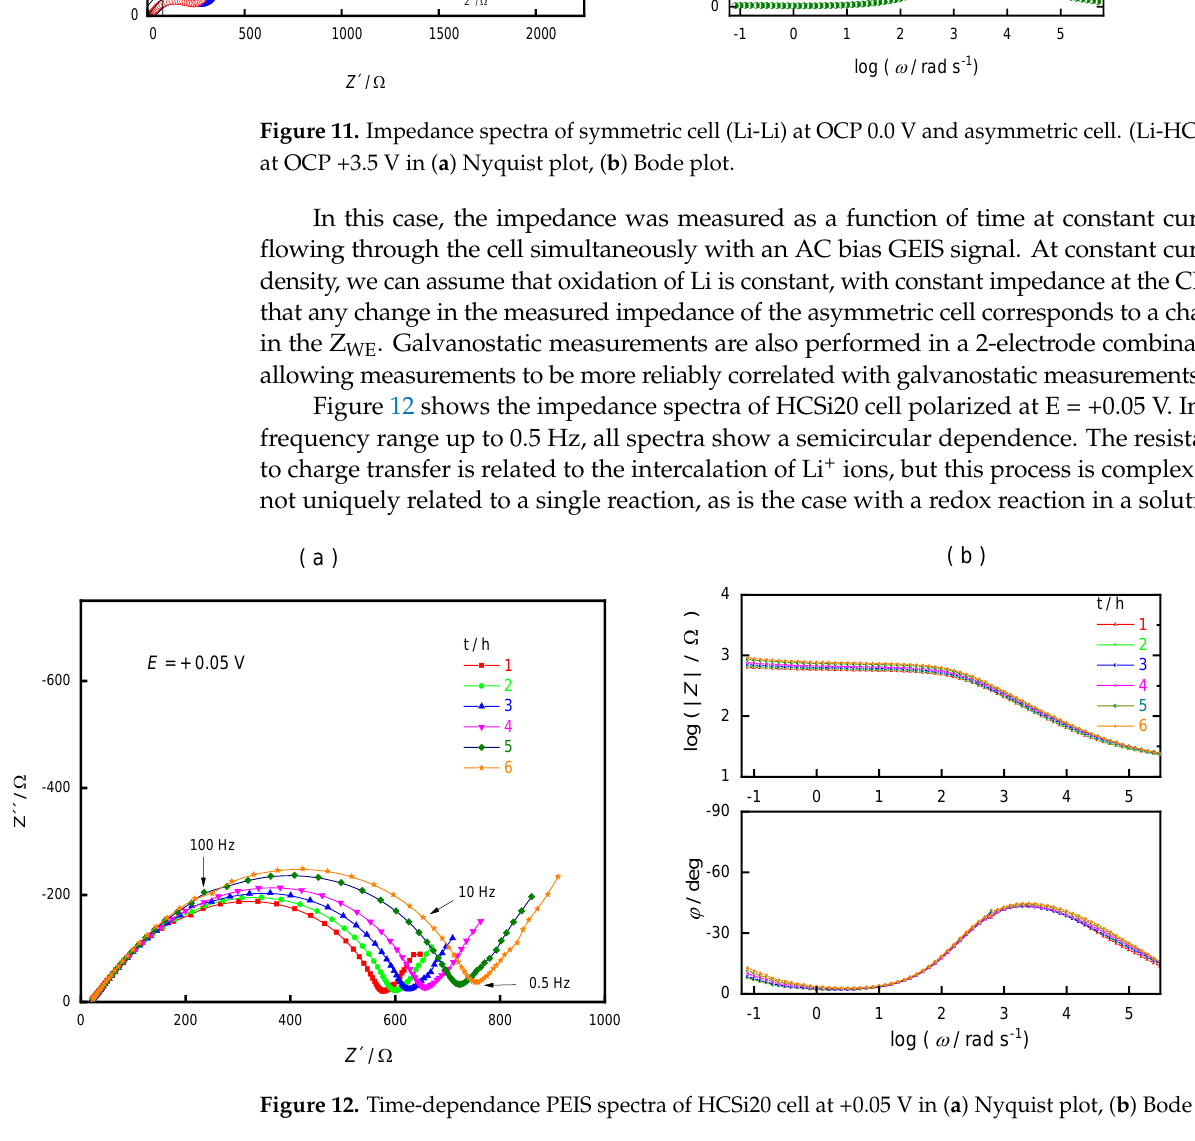
Figure 12. Time-dependance PEIS spectra of HCSi20 cell at +0.05 V in ( a ) Nyquist plot, ( b ) Bode plot. A HF semicircular dependence (Figure 12) associated with the R ct shows significant asymmetry connected only with the mechanism of intercalation of Li + ions, which is not the case at Figure 13 where R ct is significantly smaller, and asymmetry is absent.